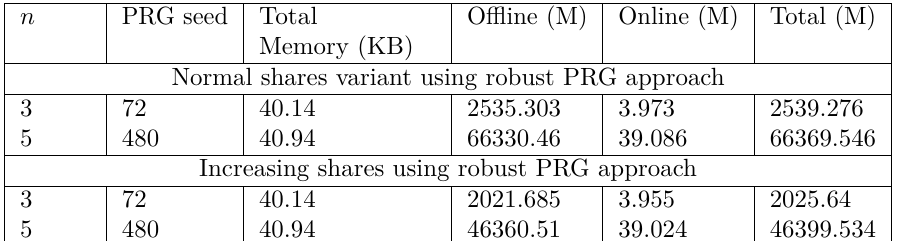
Table 5: Higher-order masked S-box computation using our variant of the table-based scheme with full pre-processing (Algorithm 4) using robust PRG technique for the normal shares (Algorithm 5) and the increasing shares variants (Algorithm 7). The true ran- dom PRG seed and the total memory required for AES-128 are given in bytes and KB, respectively. The offline, online and total execution are represented in millions of clock